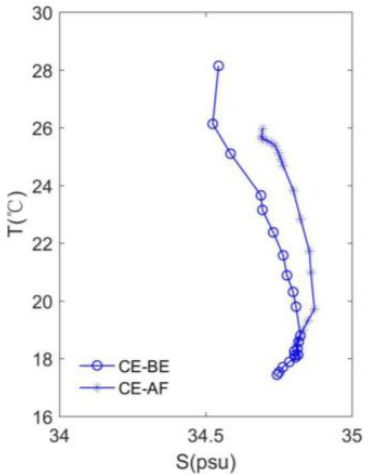
Figure 4. The T-S plot of the upper ocean (from surface to 200 m) inside the cyclonic eddy (CE). “AF” and “BE” mean after typhoon passage and before typhoon passage, respectively.